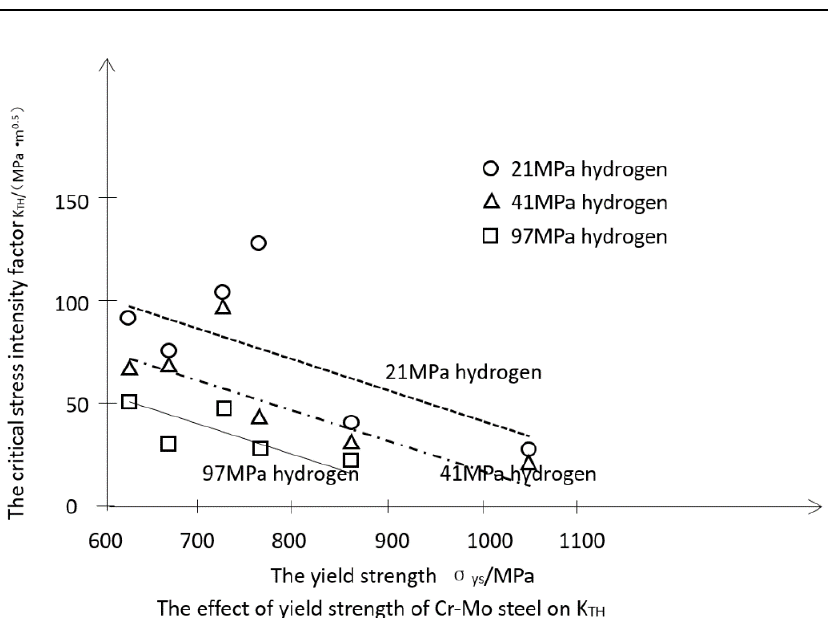
Figure 7. Effect of yield strength on the K TH of chrome-molybdenum steel. The “Solid line” refers to the 97 MPA high-pressure hydrogen environment, the “dashed line” indicates in the 41 MPA high-pressure hydrogen environment, the “dotted line” indicates in the 21 MPA high-pressure hydrogen environment. K TH is the critical stress intensity factor in the fracture mechanics evaluation.